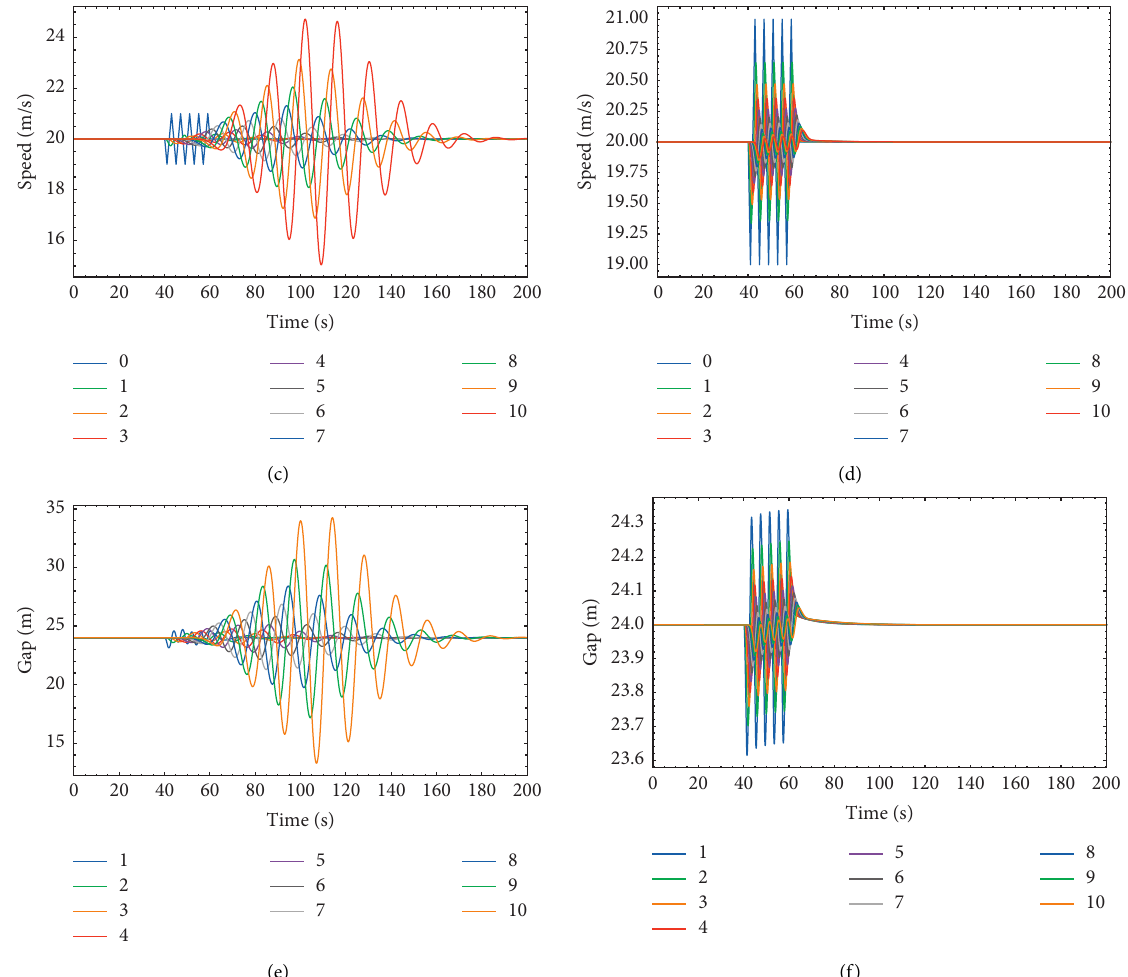
Figure 5: Platoon dynamic comparison of CTG policy (left column) and VTG policy (right column) in traffic oscillation when penetration of ACC is 1. (a) Time history of acceleration. (b) Time history of acceleration. (c) Time history of speed. (d) Time history of speed. (e) Time history of gap. (f) Time history of gap.